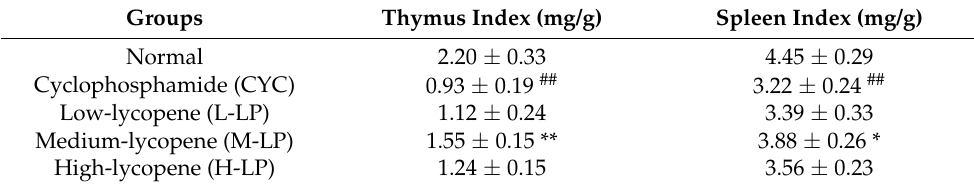
Table 1. Thymus and spleen indexes of mice in each group. Groups Thymus Index (mg/g) Spleen Index